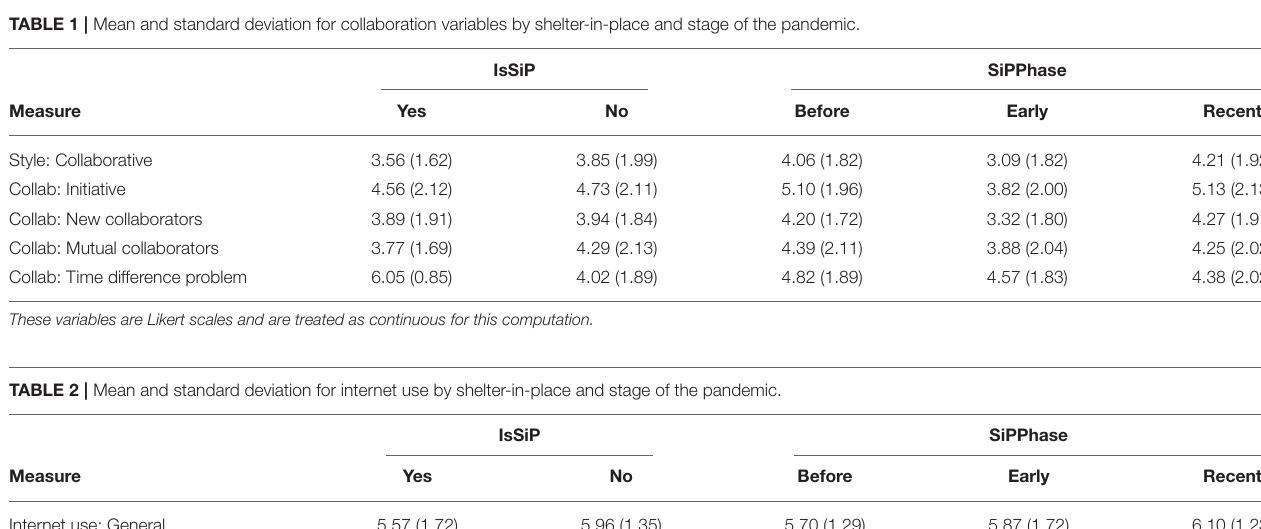
TABLE 1 | Mean and standard deviation for collaboration variables by shelter-in-place and stage of the pandemic. IsSiP SiPPhase Measure